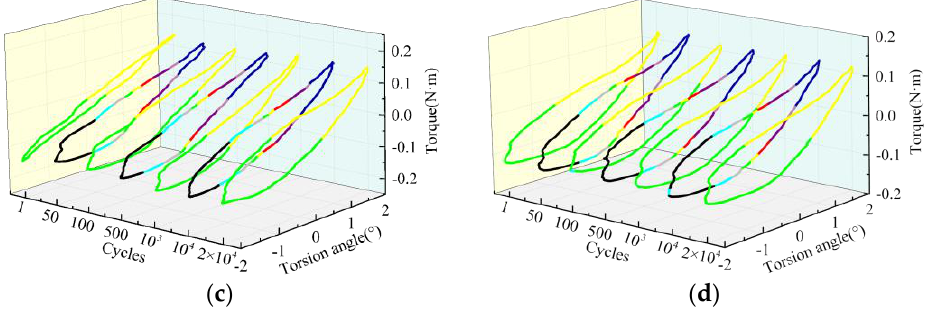
Figure 11. Evolutions and dissipation energy of torque versus torsion angle during tension–torsion cyclic loading at different crossing angles. ( a ) β = 90°. ( b ) β = 70°. ( c ) β = 45°. ( d ) β = 26°.